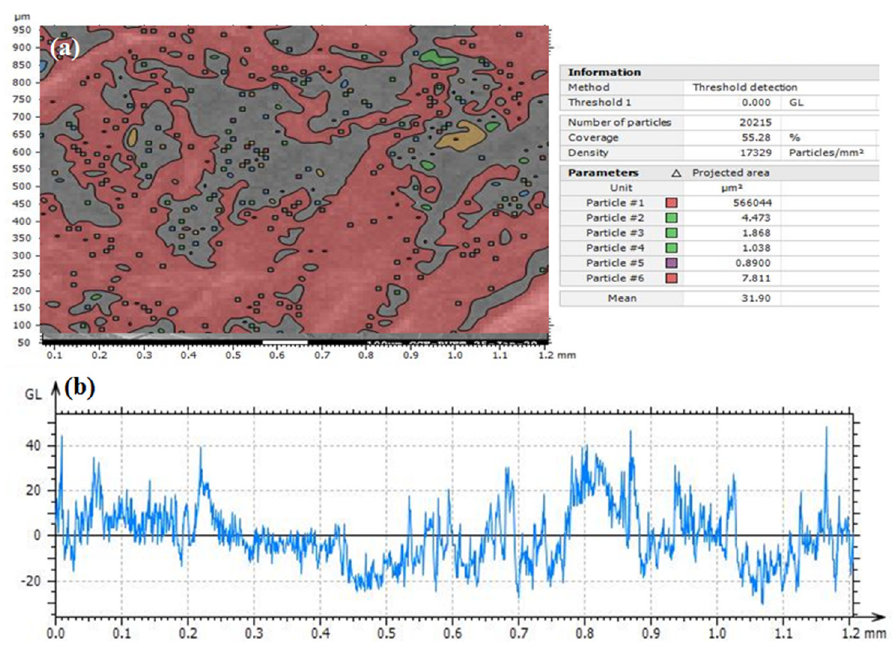
Figure 8. Particle analysis of JCJC spent tea leaf composites, ( a ) particle size detection and ( b ) surface profile.